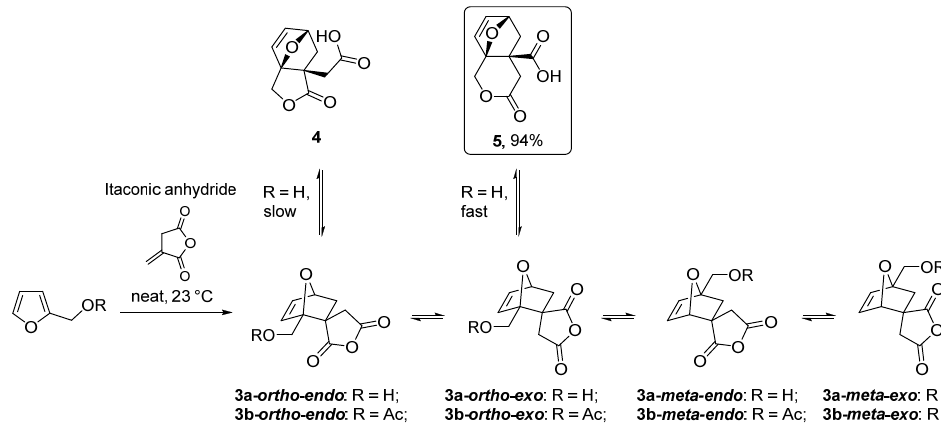
Scheme 5. Diels—Alder reactions of FA and FA acetate with itaconic anhydride. Overall, the diastereoselectivity of DA reactions of alkenes with FF derivatives con- taining donor substituents at the C2 position is not always predictable, because it strongly depends on the structure of both the diene and dienophile. More predictable diastereose- lective construction of functionalized oxabicyclic structures may be performed using HMF-derived 2,5-disubstituted furans that predominantly react with cyclic alkenes with high endoselectivity (Table 4, entries 1–2; Table 5, entry 24) [33,43,106,108].